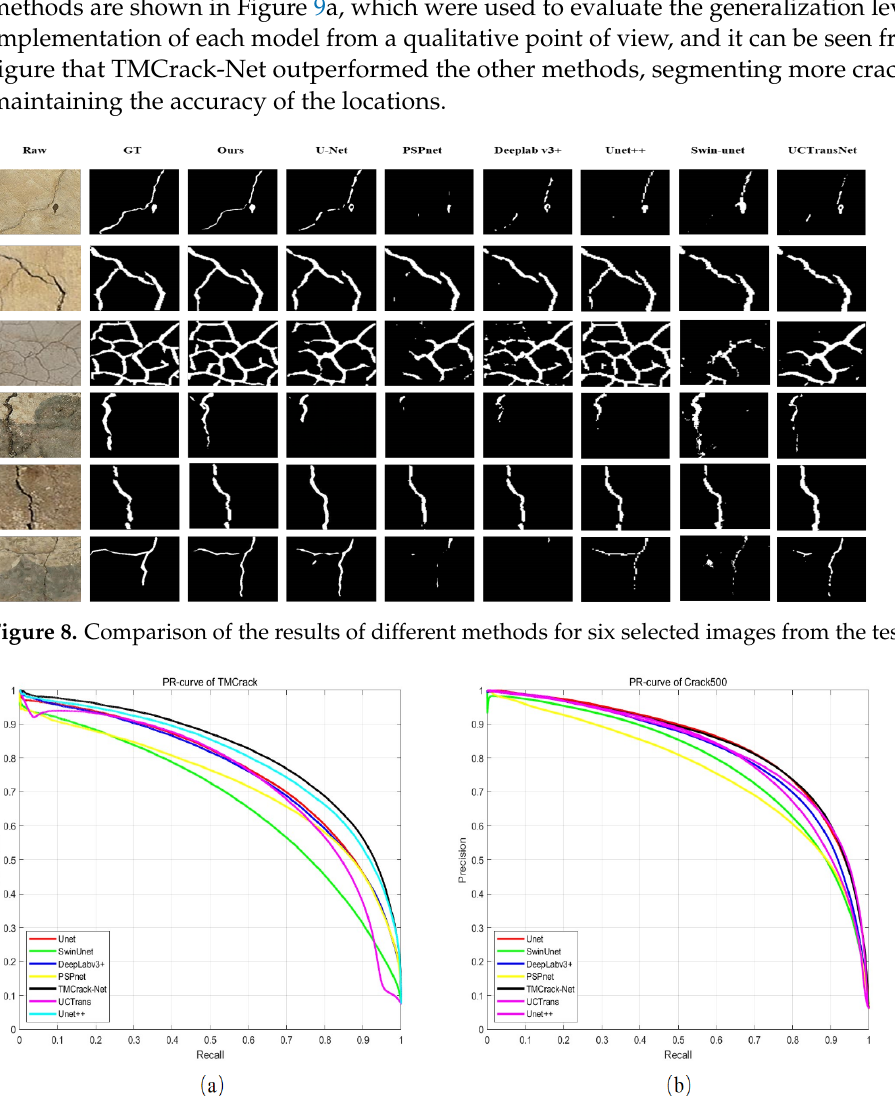
Figure 9. ( a ) Precision–recall curves for different models on TMCrack. ( b ) Precision–recall curves for different models on